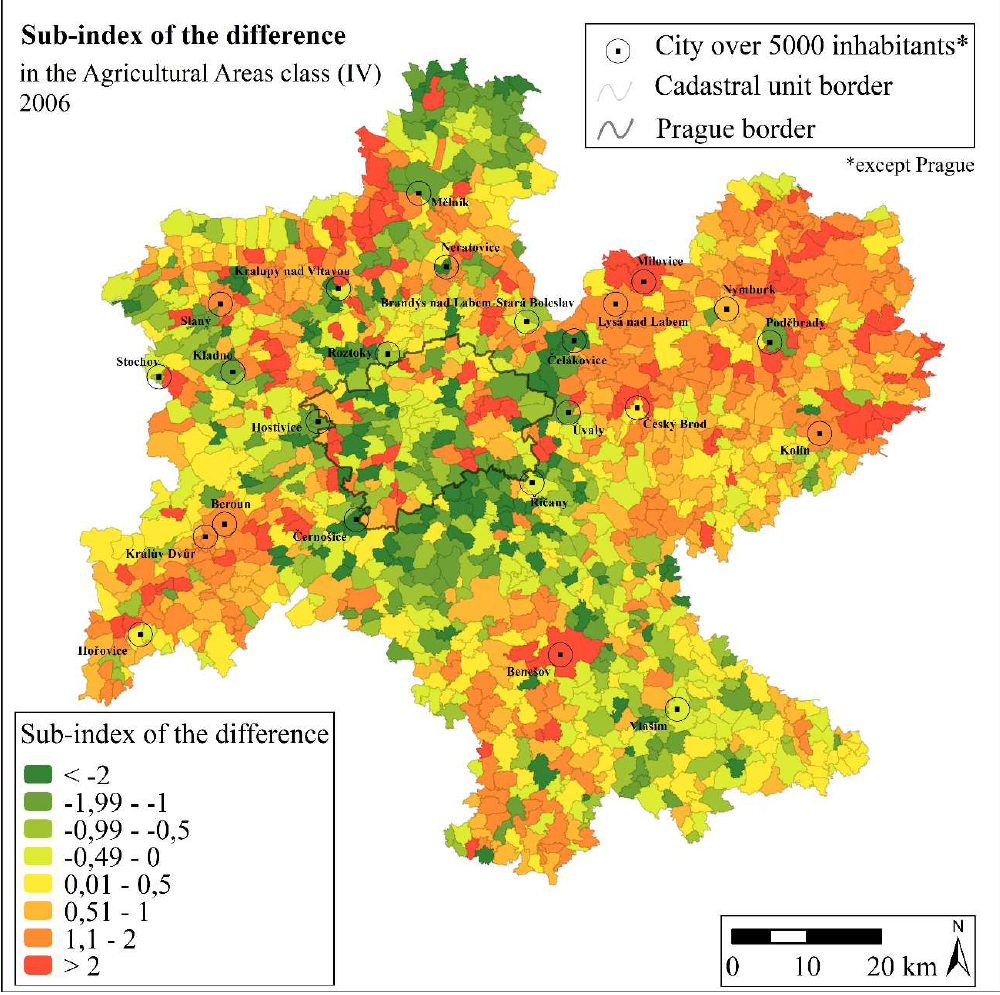
Figure 5. DIs in the Agricultural Area Class (IV), 2006. Source: [31,33].